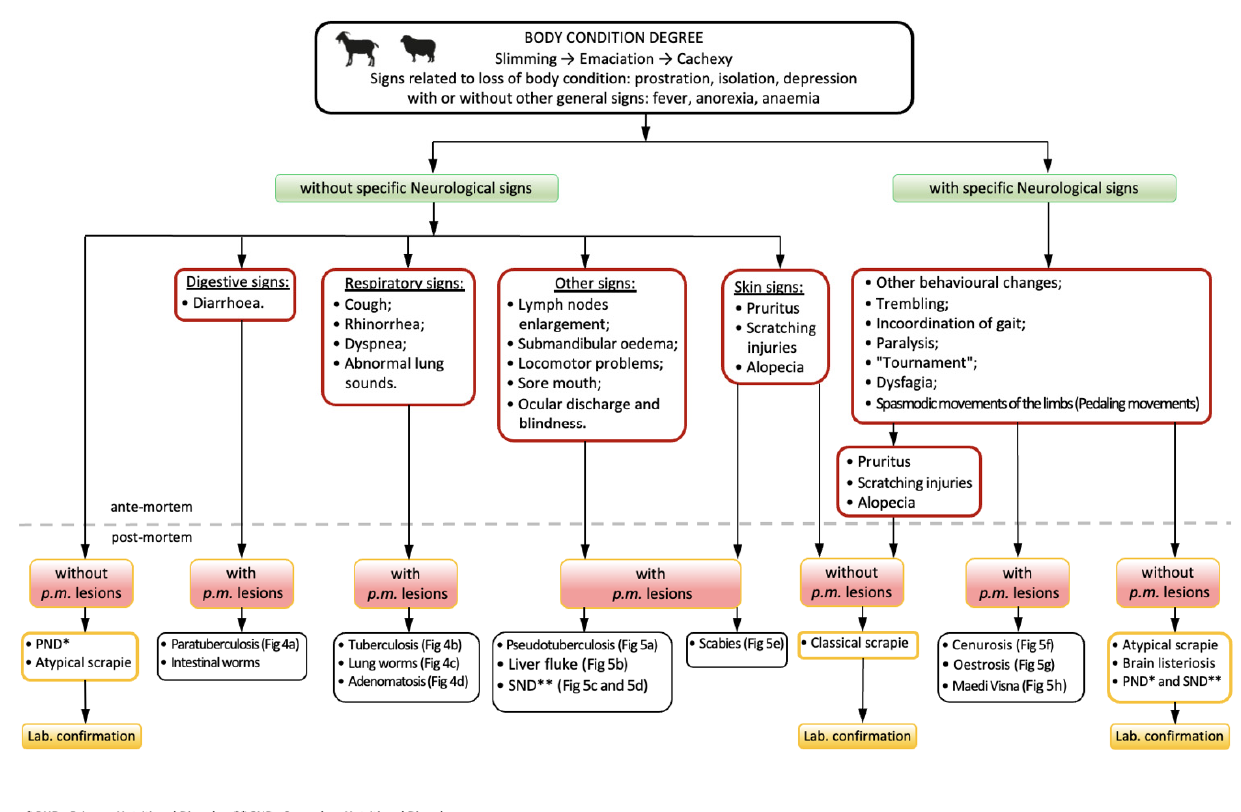
Figure 3. Sanitary Inspection of Wasting condition in small ruminants.